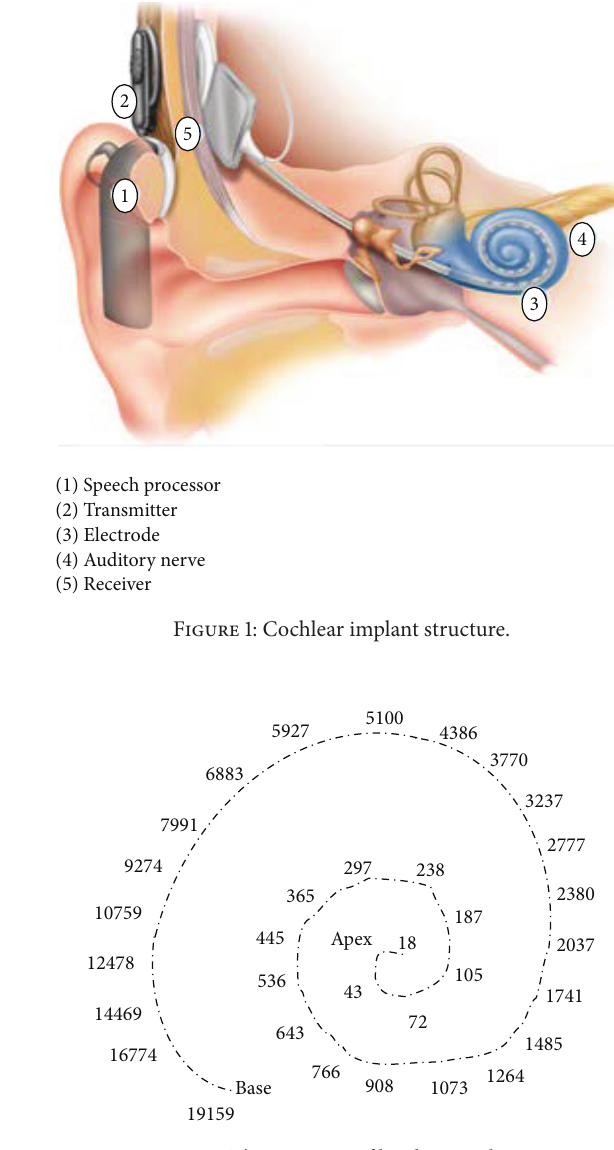
Figure 2: The structure of basilar